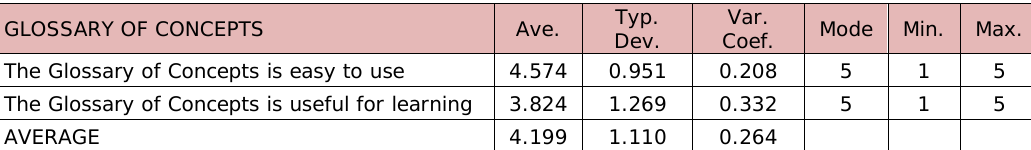
Table 5. “Assessment of Glossary of